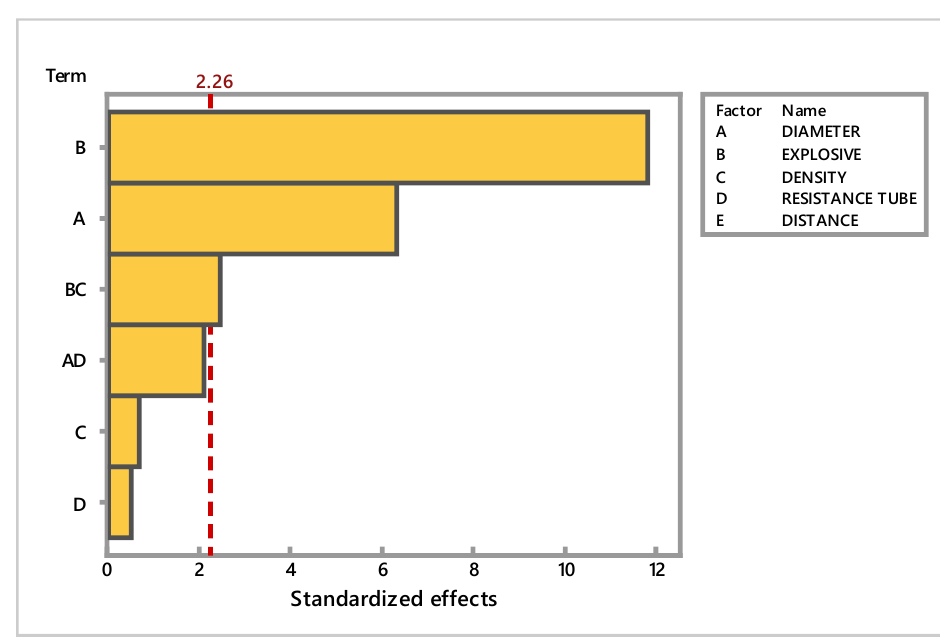
Figure 10. Pareto diagram of absolute values of the standardized effects.